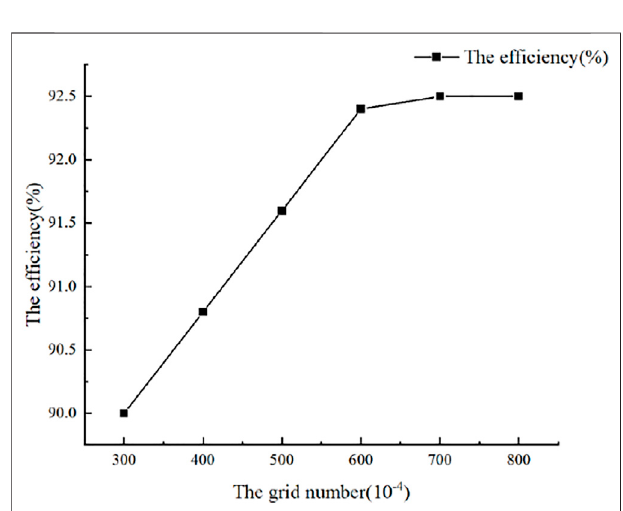
FIGURE 3 | Grid independence veri fi